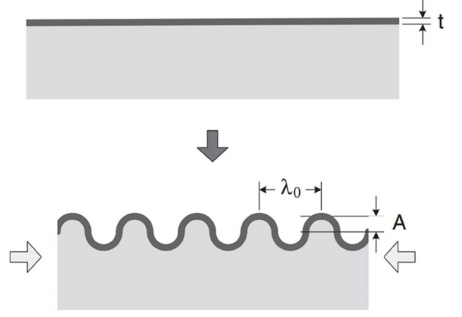
Figure 1. Illustration of the general mechanisms for forming wrinkles in bilayered systems comprising a rigid top layer on an elastic substrate. Reproduced with permission from ref. [35]. Copyright 2010, John Wiley & Sons, Inc.